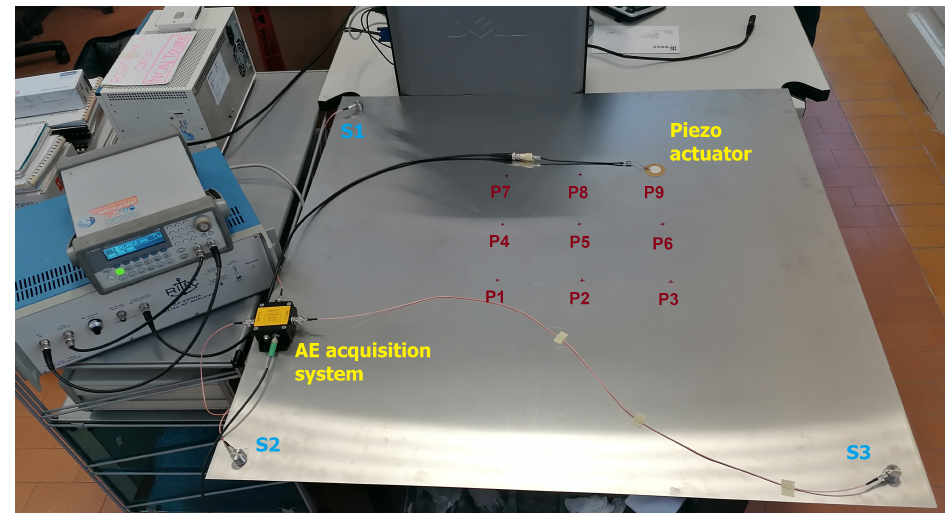
Figure 9. A photo of the experimental